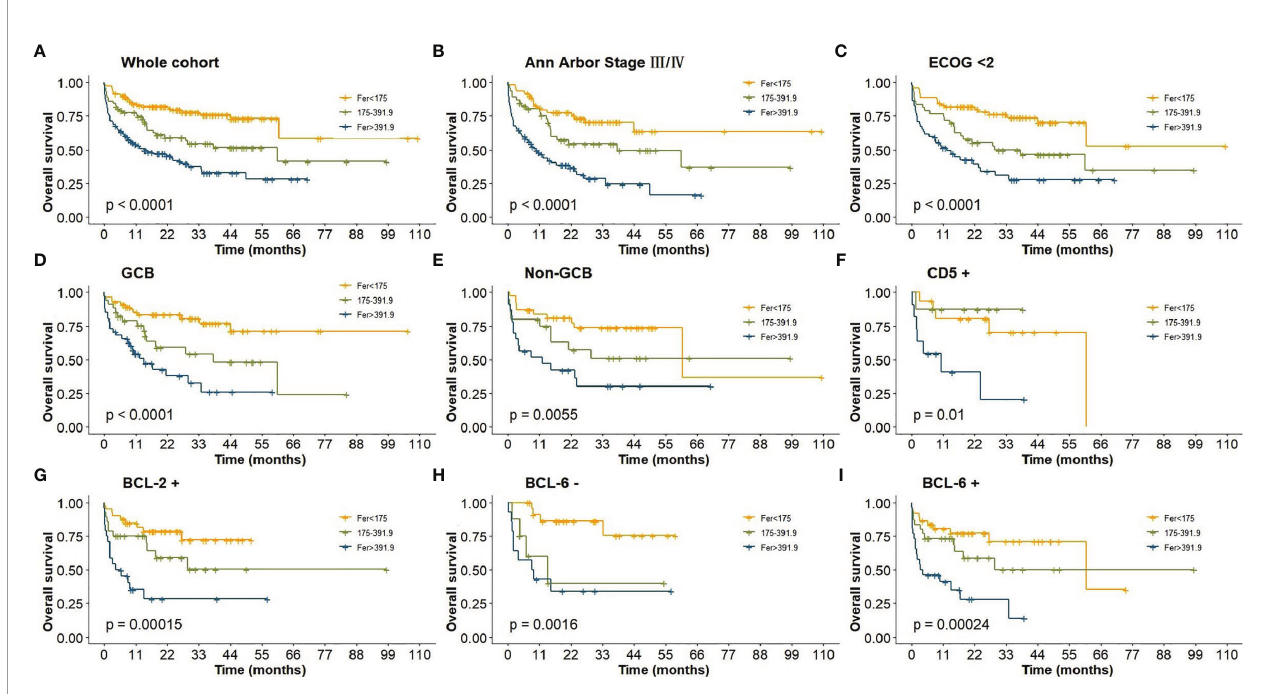
FIGURE 2 | (A) OS of DLBCL patients in whole cohort; (B) OS of Ann Arbor Stage III/IV; (C) OS of ECOG (<2); (D – E) OS of cell-of-origin; (F) OS of CD5+; (G) OS of BCL-2+; (H – I) OS of BCL-6.